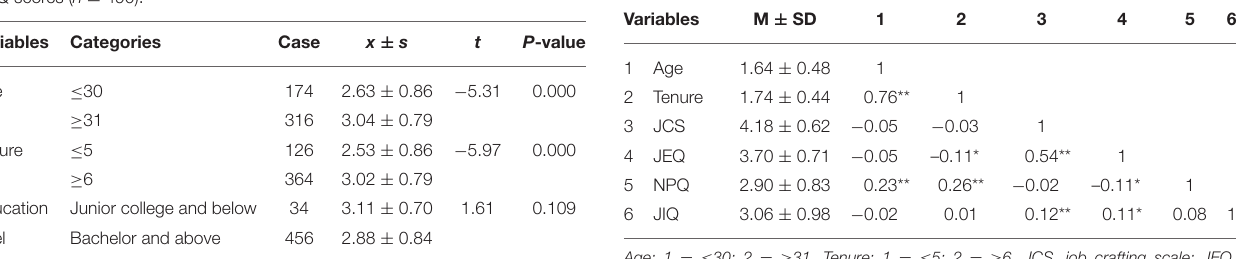
TABLE 1 | Descriptions and correlations among demographic characteristics and NPQ scores ( n = 490).